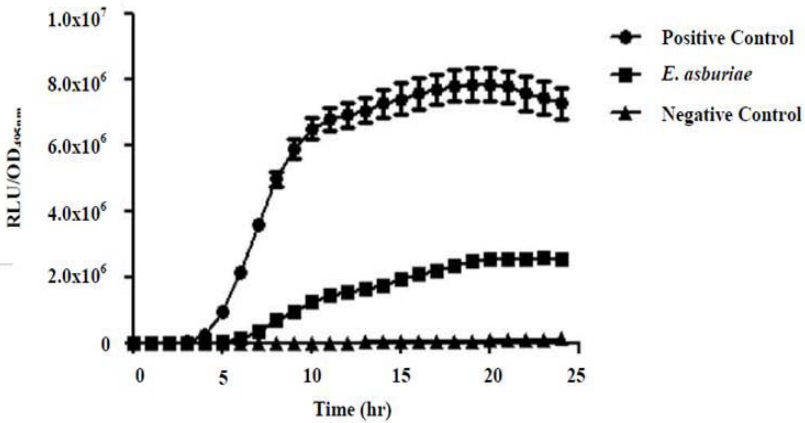
Figure 3. Detection of AHL production by E. asburiae . Bioluminescence measurement was done for 24 h, 37 °C growth in the presence of AHL extracted from spent culture supernatant of E. asburiae , synthetic 3-oxo-C6-HSL and acetonitrile as positive control and negative controls, respectively. Biosensor E . coli [pSB401] served as the biosensor. Data are presented as means of ± SEM values of triplicate